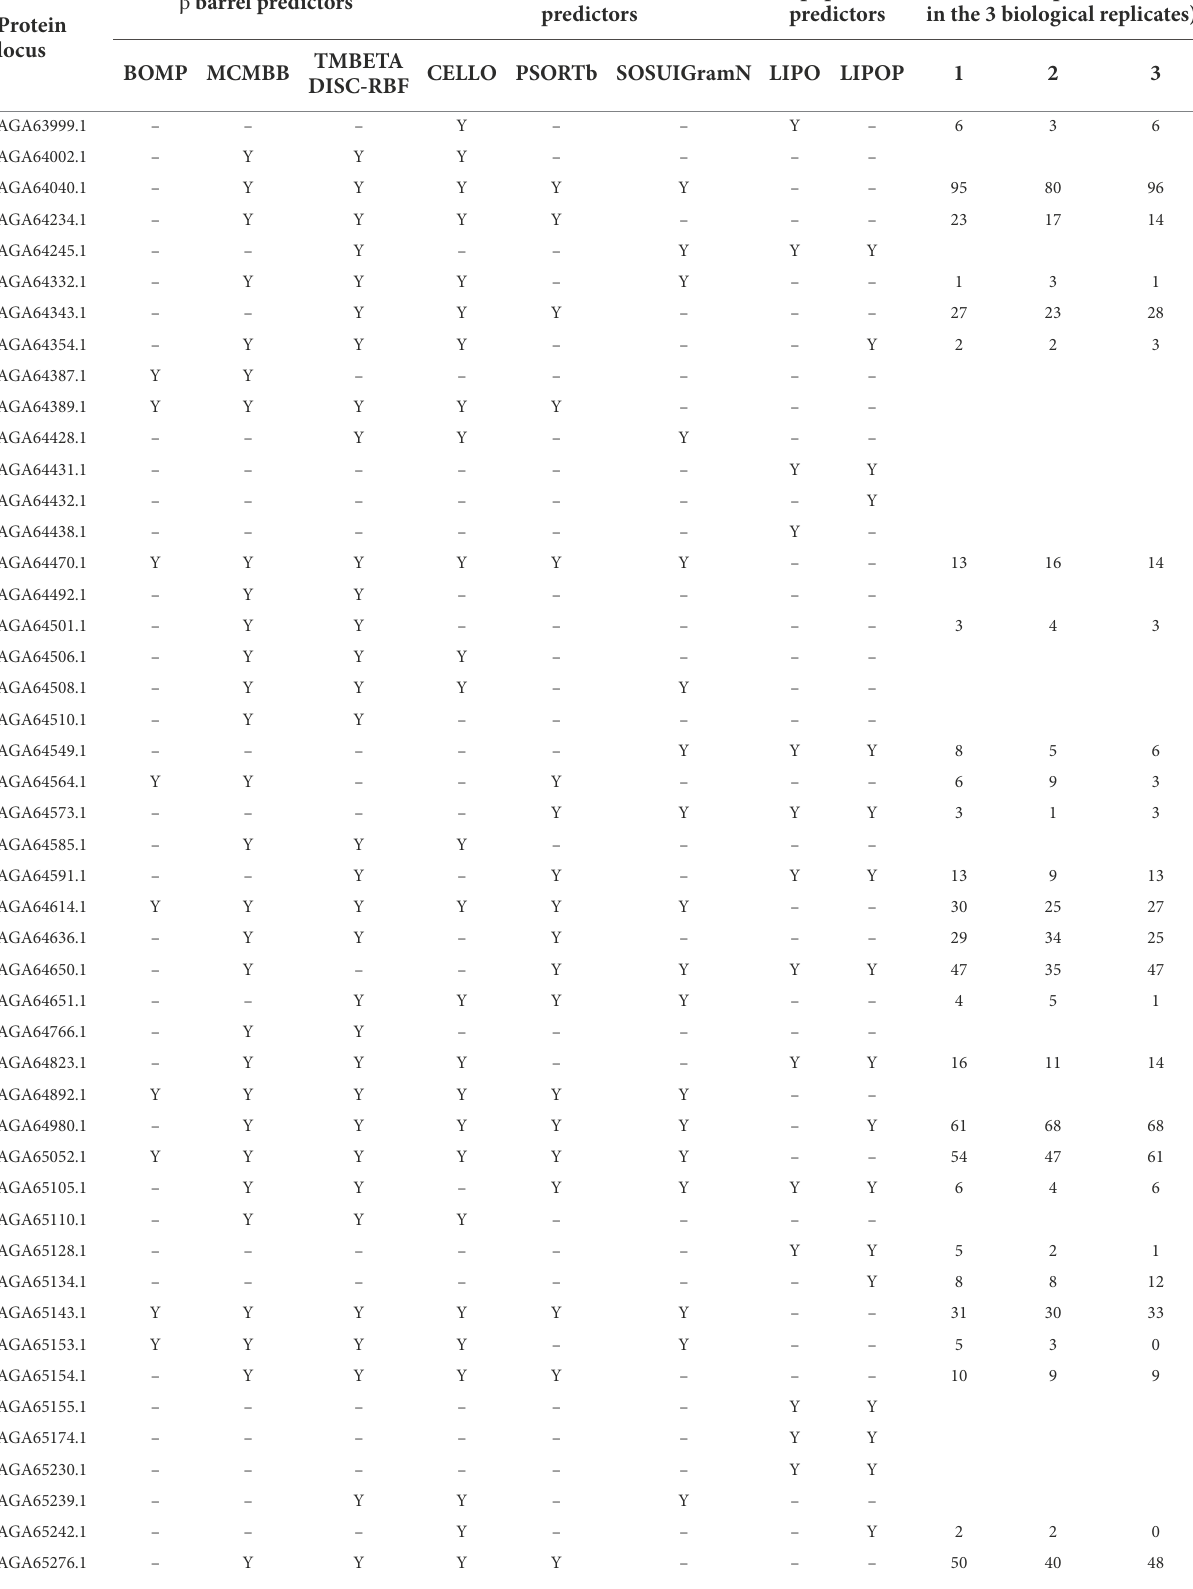
TABLE 2 Bioinformatic prediction of outer membrane proteins in Liberibacter crescens BT-1 and the LC–MS/MS results of proteins which were also identified from bacterial outer membrane fraction. Sub-cellular localization β barrel predictors Protein locus